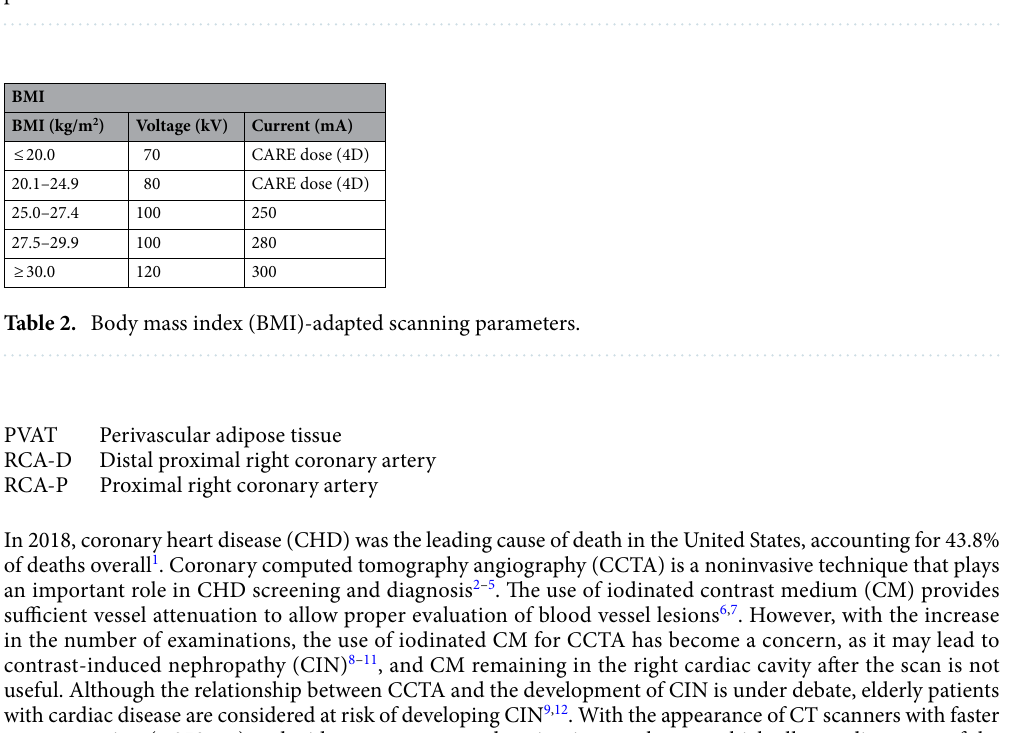
Table 1. Body surface area (BSA)-adapted and body mass index (BMI)-adapted contrast-medium injection protocol.